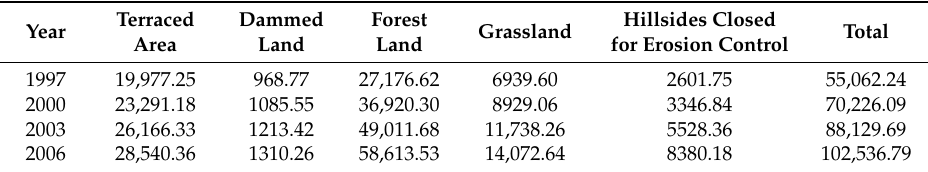
Table 8. Implementation of different soil and water conservation in the Tou-Long region in 1997, 2000, 2003, and 2006 (unit: km 2